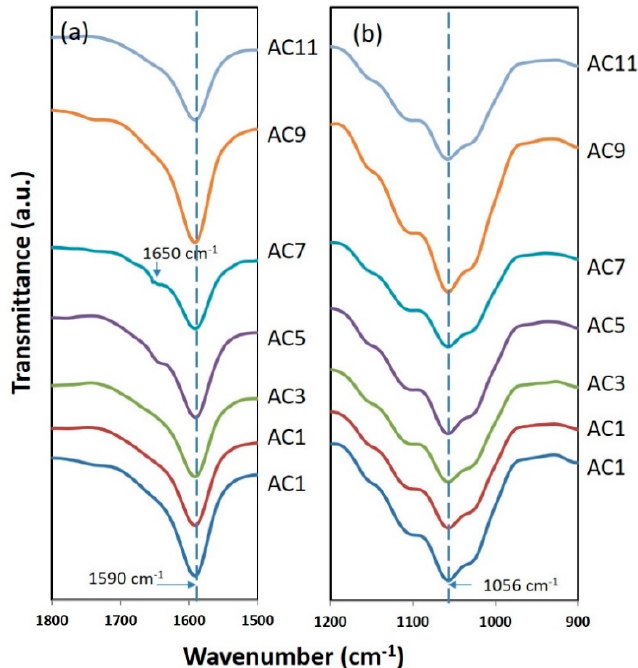
Figure 2. Fourier transform infrared (FTIR) spectra of CMC-AC biopolymer films range from ( a ) 1500–1800 cm − 1 and ( b ) 900–1200 cm − 1 .